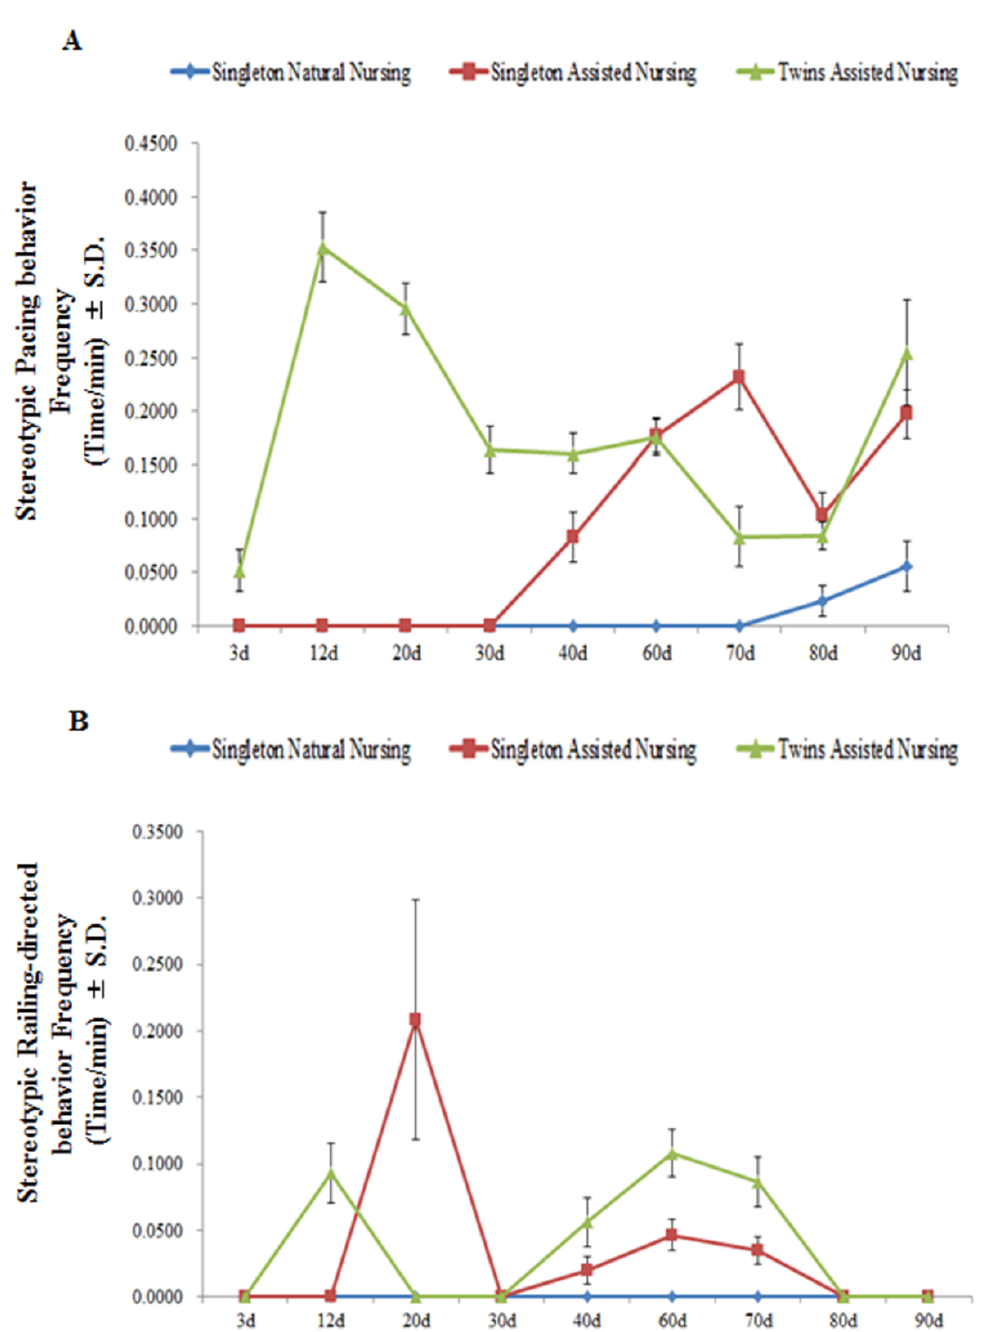
Figure 5. Changes in panda mothers’ pacing behaviors (panel A ) and railing-directed behaviors (panel B ) when the cubs were removed from the mothers. Data were presented as the mean ± S.D. (standard deviation). n = 3 per group.